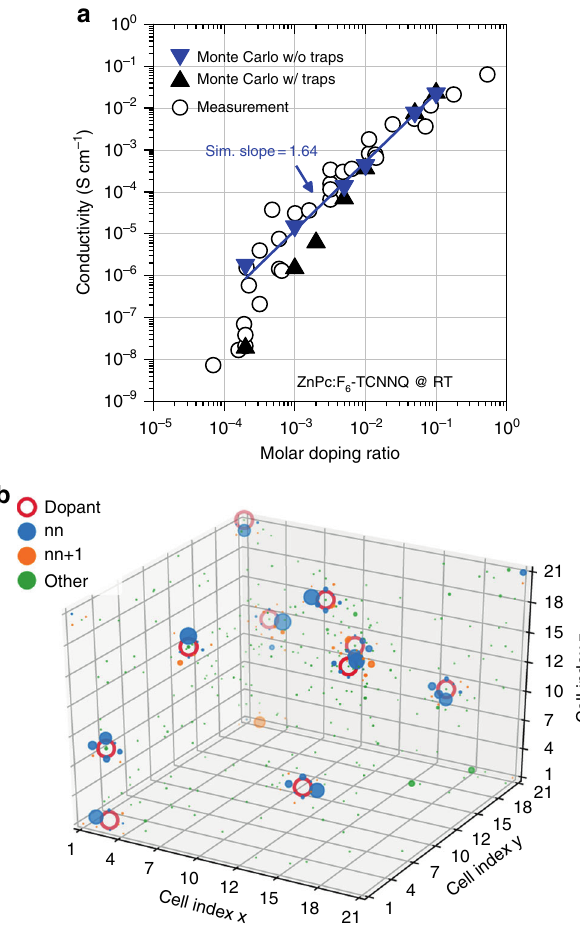
Fig. 5 Monte Carlo simulation of the conductivity. a Super-linear scaling of the conductivity vs. doping ratio for ZnPc:F 6 -TCNNQ at RT. Experimental values are taken from ref. 10 , the simulation yields a log – log slope ~ 1.64. At low doping ratios, deep traps with N T = 7.2 × 10 17 cm − 3 are fi lled. b Illustration of the simulated occupation probability W of sites with charge carriers (holes) in a 21 × 21 × 21 mesh with periodic boundary conditions and MR = 10 − 3 (10 dopants, without traps). Blue and orange dots represent the occupation probabilities of nearest-neighbor (nn) and next nearest- neighbor (nn + 1) sites of dopants, respectively, which positions are marked as red circles. For all other sites, the occupation probability is indicated by green dots. The apparently isolated orange dot at site (2,21,1) is associated to the dopant at site (1,21,21), i.e., its equivalent in the bottom periodic replica of the shown mesh. The occupation probability W increases with the plotted dot size each, here shown for a threshold of W > 10 − 4 . Dots located at positions farther away from the viewing angle are plotted with higher transparency. A respective site occupation plot considering deep trap states is given in Supplementary Figure